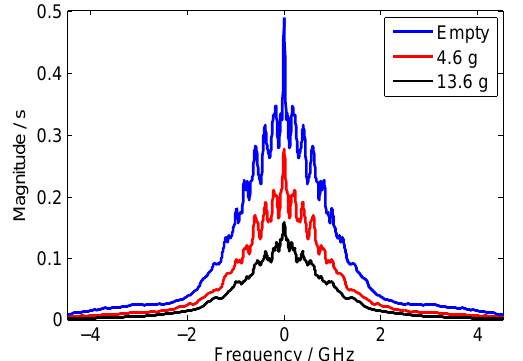
Figure 16. Histogram of the UWB magnitude spectrum for differ- ent loading states (bars) and best fits by exponential distributions p ( x ) = β − 1 e − x/β